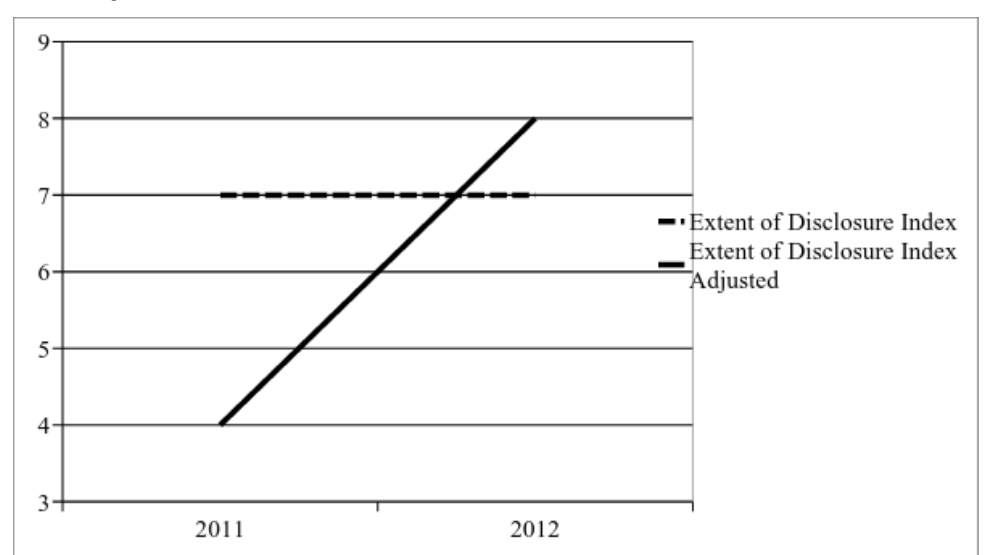
Graphic: adjusted rankings for Italy (Extent of Disclosure